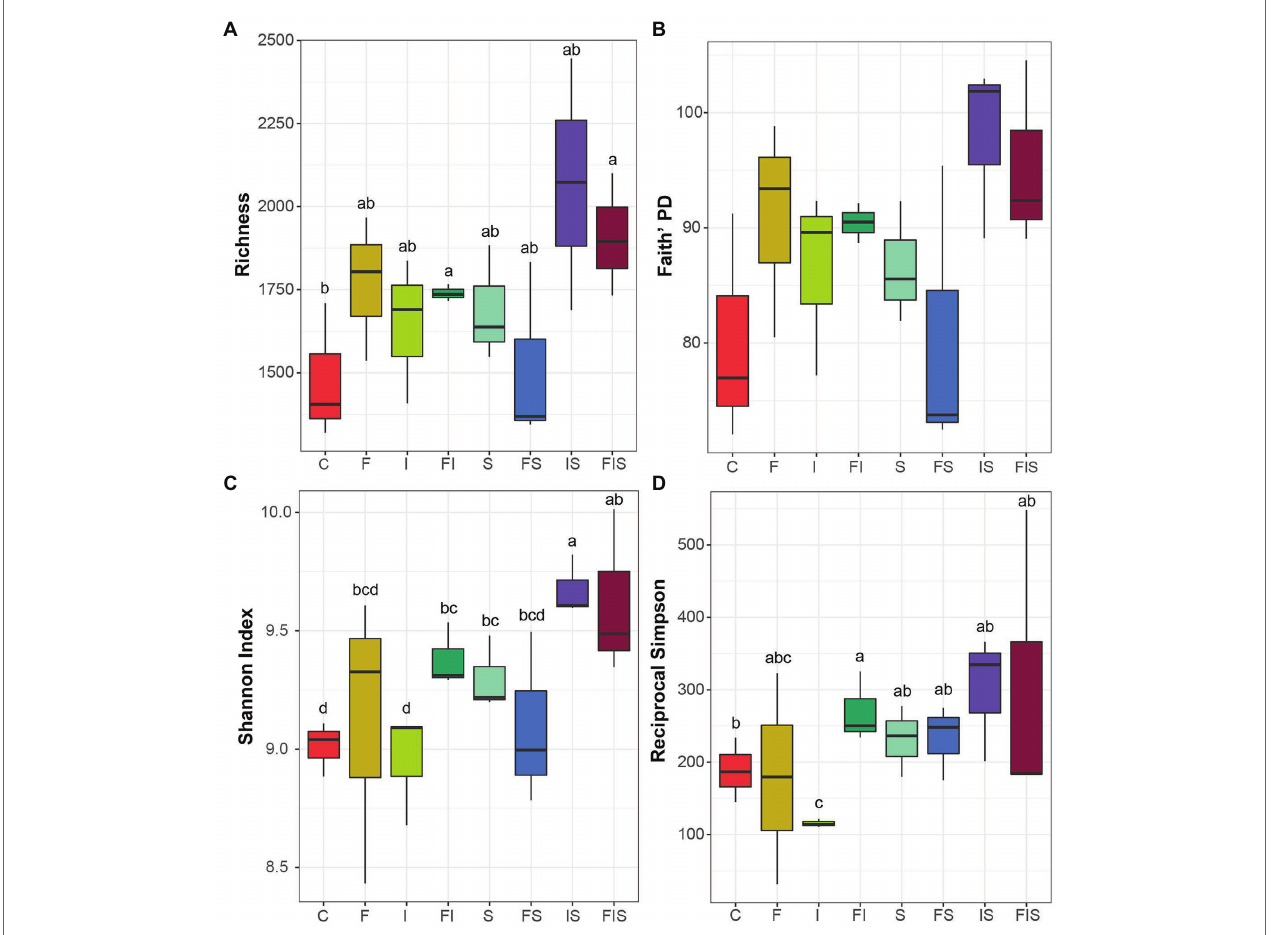
FIGURE 4 | Alpha diversity boxplots from the rhizosphere microbial communities (order level) at the V15 stage: (A) total species richness, (B) Faith’s phylogenetic diversity, (C) Shannon index, and (D) Reciprocal Simpson index (1/D). Boxplots with the same letter or in absence are not significantly different ( p < 0.05). Treatments: C, Control; F, Urea-topdressing fertilization at V5; I, A. brasilense inoculant on seeds sowing; FI, F + I; S, Maize stover coverage; FS, F + S; IS, I + S; FIS, F + I +